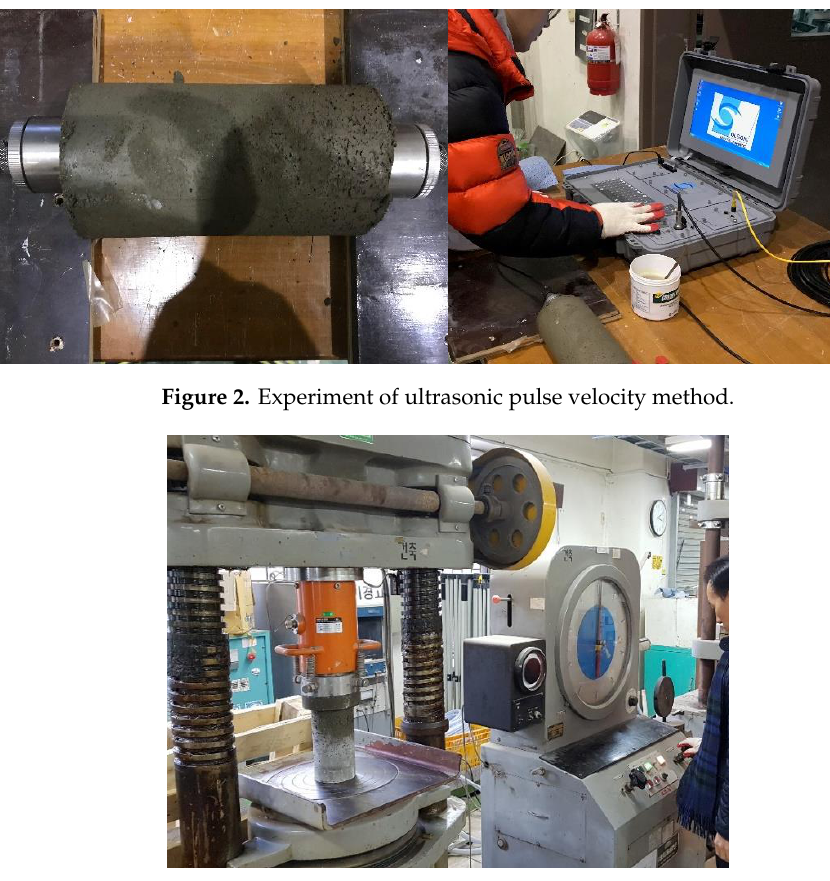
Figure 3. Testing method for compressive strength of molded concrete cylinders.